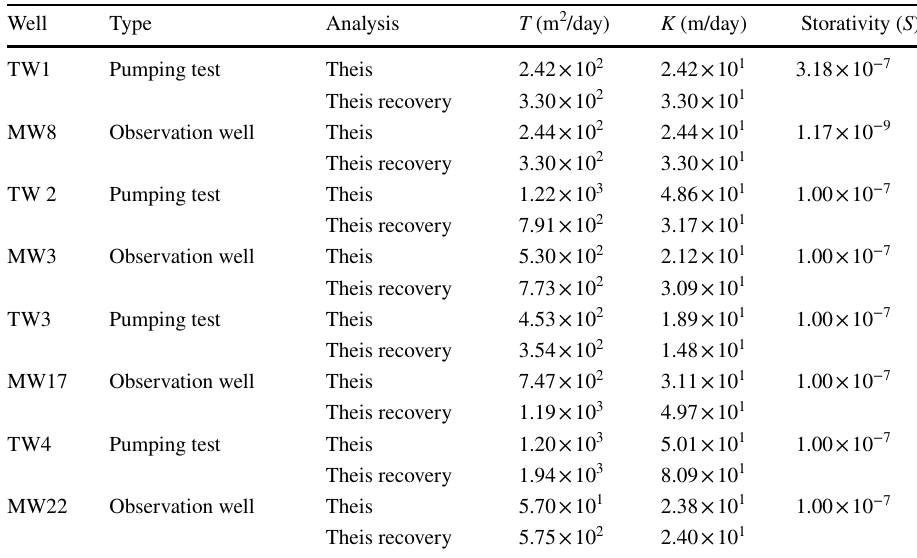
Table 7 Results of transmissivity ( T ), hydraulic conductivity ( K ) and storativity ( S ) from pumping test and observation wells